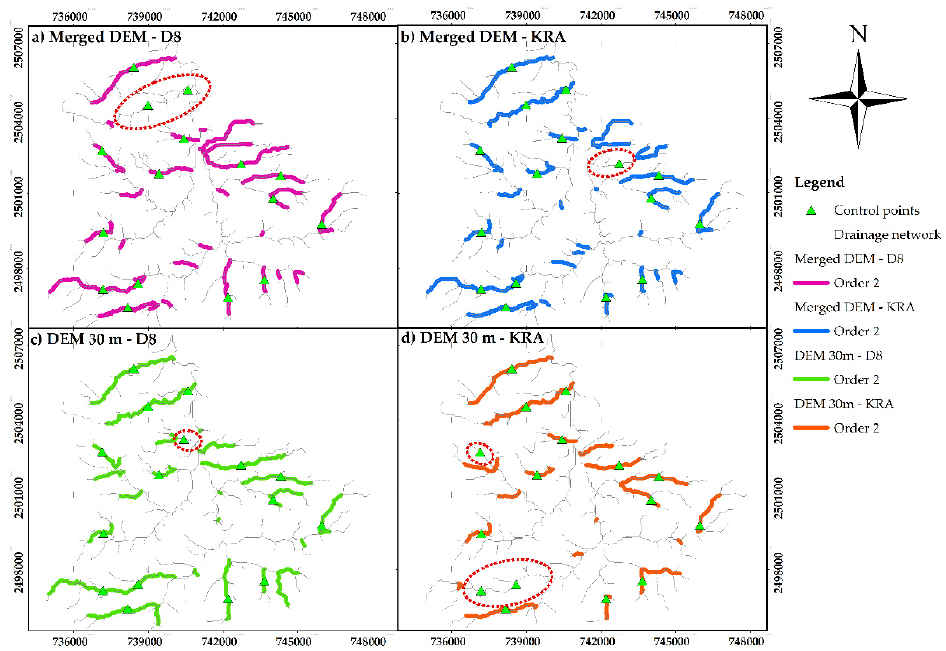
Figure 8. Drainage networks, control points, and channels of stream order 2.